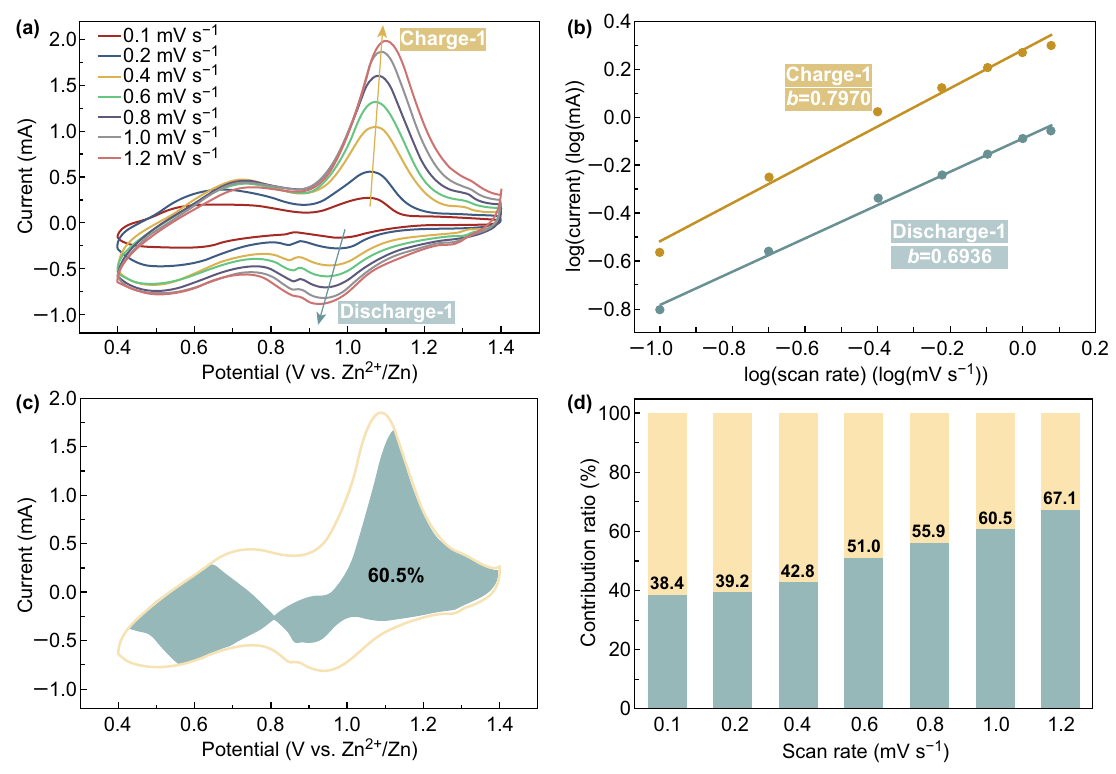
Fig. 3 a CV curves at 0.1–1.2 mV s −1 for HAVO@G. b Log( i ) versus log( v ) plots at specific peak currents in a . c CV curve with the calculated pseudocapacitive fraction shown by the shaded area at 1 mV s −1 , and d Bar chart showing the percent of calculated pseudocapacitive contribu- tion at 0.1–1.2 mV s